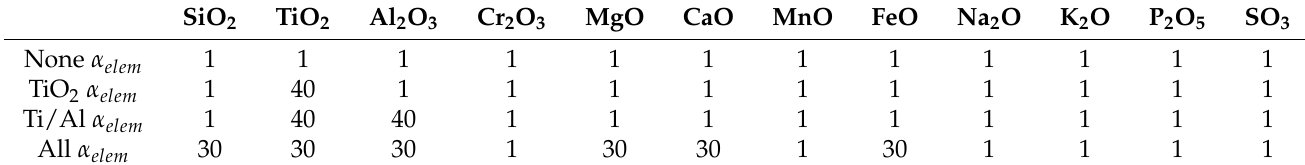
Table 2. Prior setups for the elemental abundances used during this work. The shape parameter β is then calculated according to Equation (21). If α elem > 1 and the theoretical elemental abundance is below 1 wt.%, the shape parameters will be set to α elem = 1 and β elem = 10.